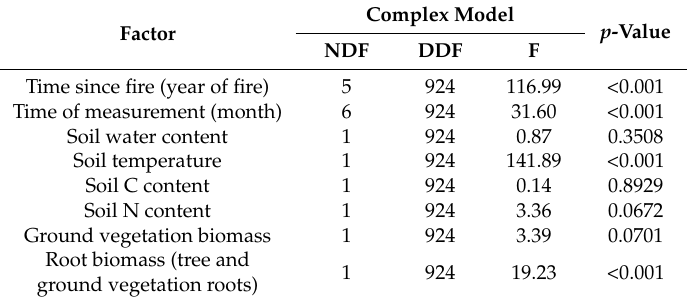
Table 2. Analysis of logarithmically transformed soil CO 2 efflux: ANOVA type 3 test results for factors.